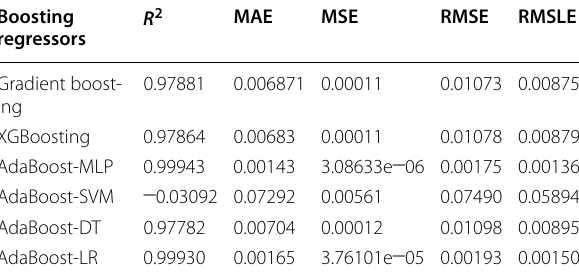
Table 4 Prediction performance of boosting techniques of ensemble method